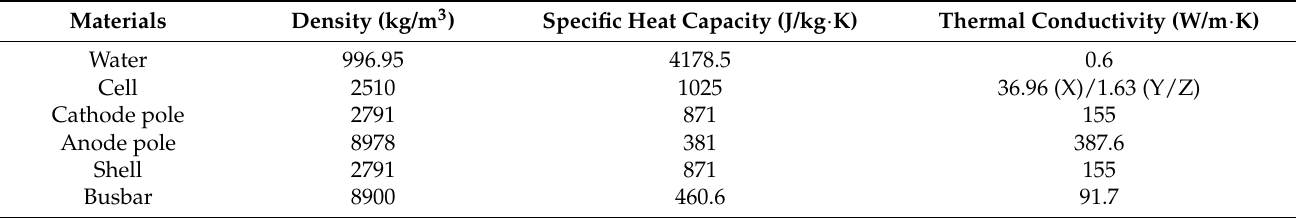
Table 1. Material thermal property